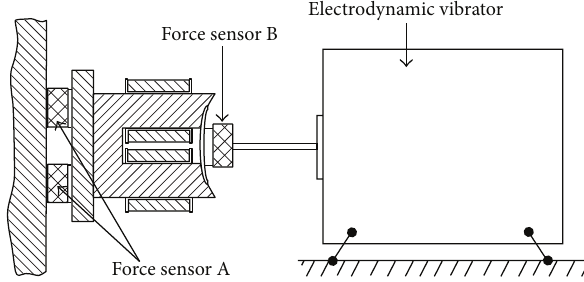
Figure 6: Test methods based on force transmissibility.